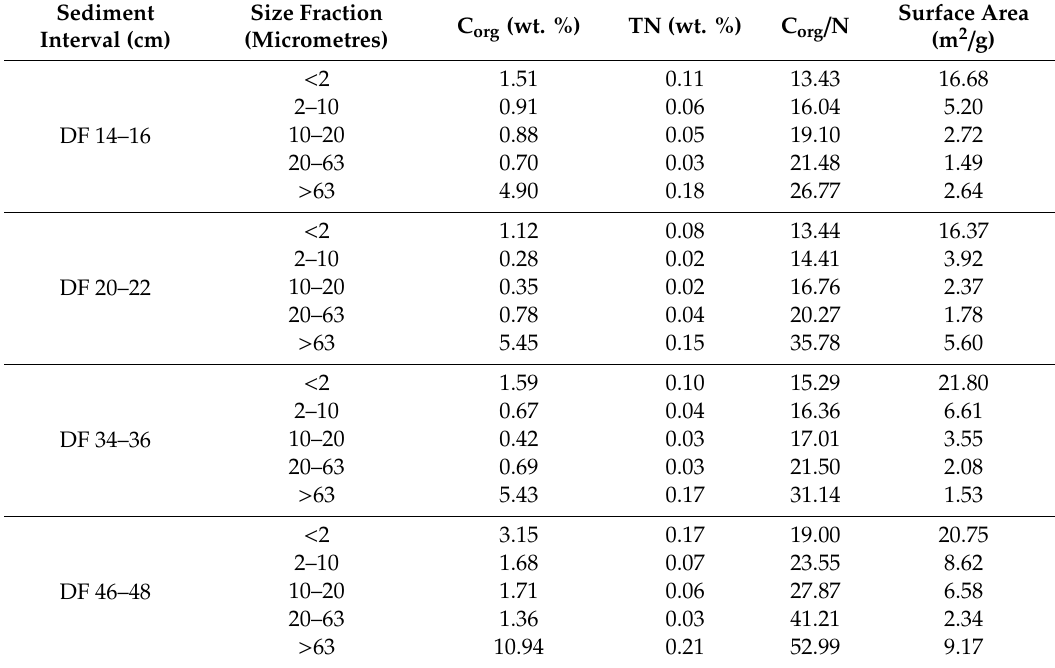
Table 5. Organic Carbon (C org ), Total Nitrogen (TN), Carbon / Nitrogen Ratio (C org / N) and Surface Area (SA) for sediment samples from selected depth intervals, size fractionated into five fractions: < 2 µ